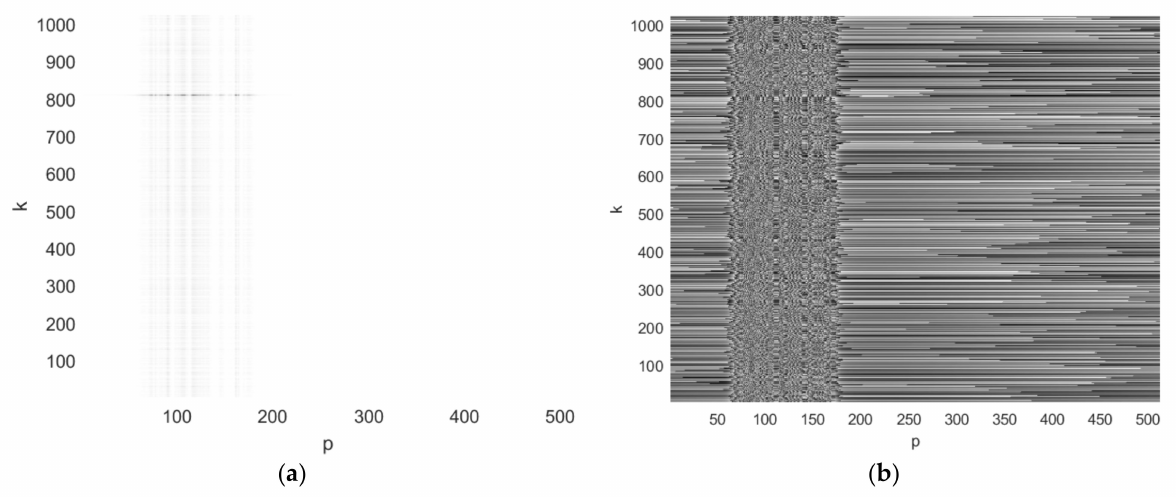
Figure 6. DVB-T BFISAR complex image: ( a ) amplitude image and ( b ) phase